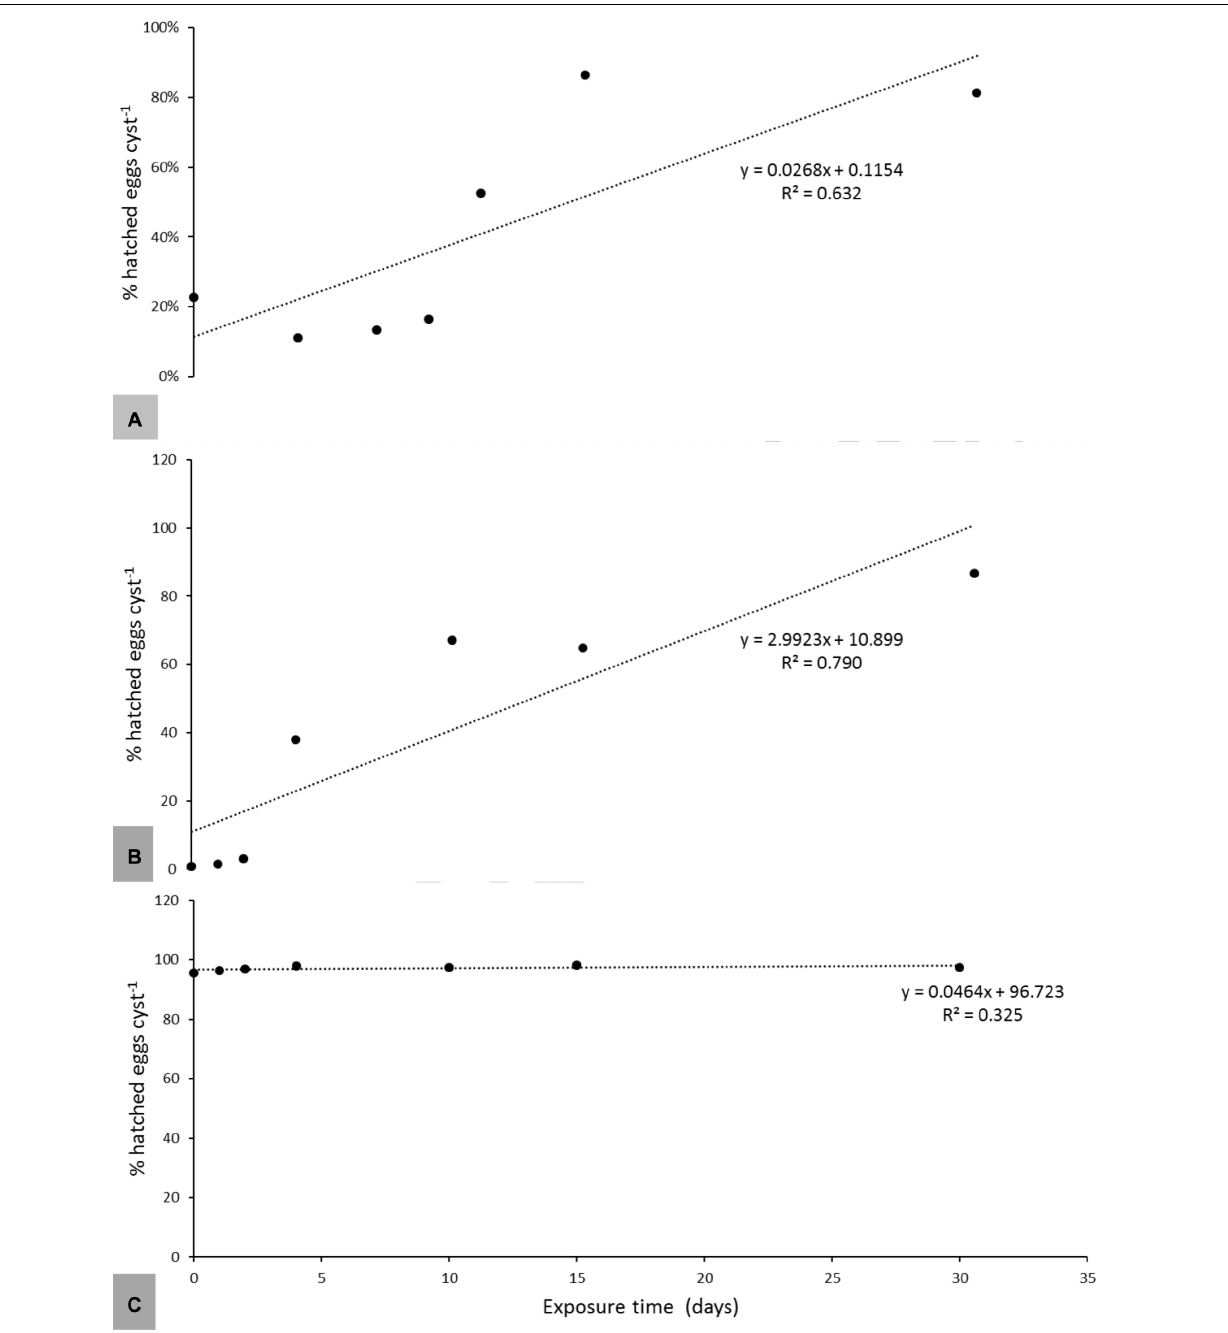
FIGURE 2 | The relationships between in vitro hatching of G. pallida (A) , H. carotae (B) , and H. schachtii (C) and exposure time to root exudates of Solanum tuberosum var. Désirée, Daucus carota cv. Touchon and Beta vulgaris cv. Acacia at 45% dilution, respectively. The regression coefficient ( R 2 ) and equations of the linear model are indicated for each potato variety. Data points represents means values of six